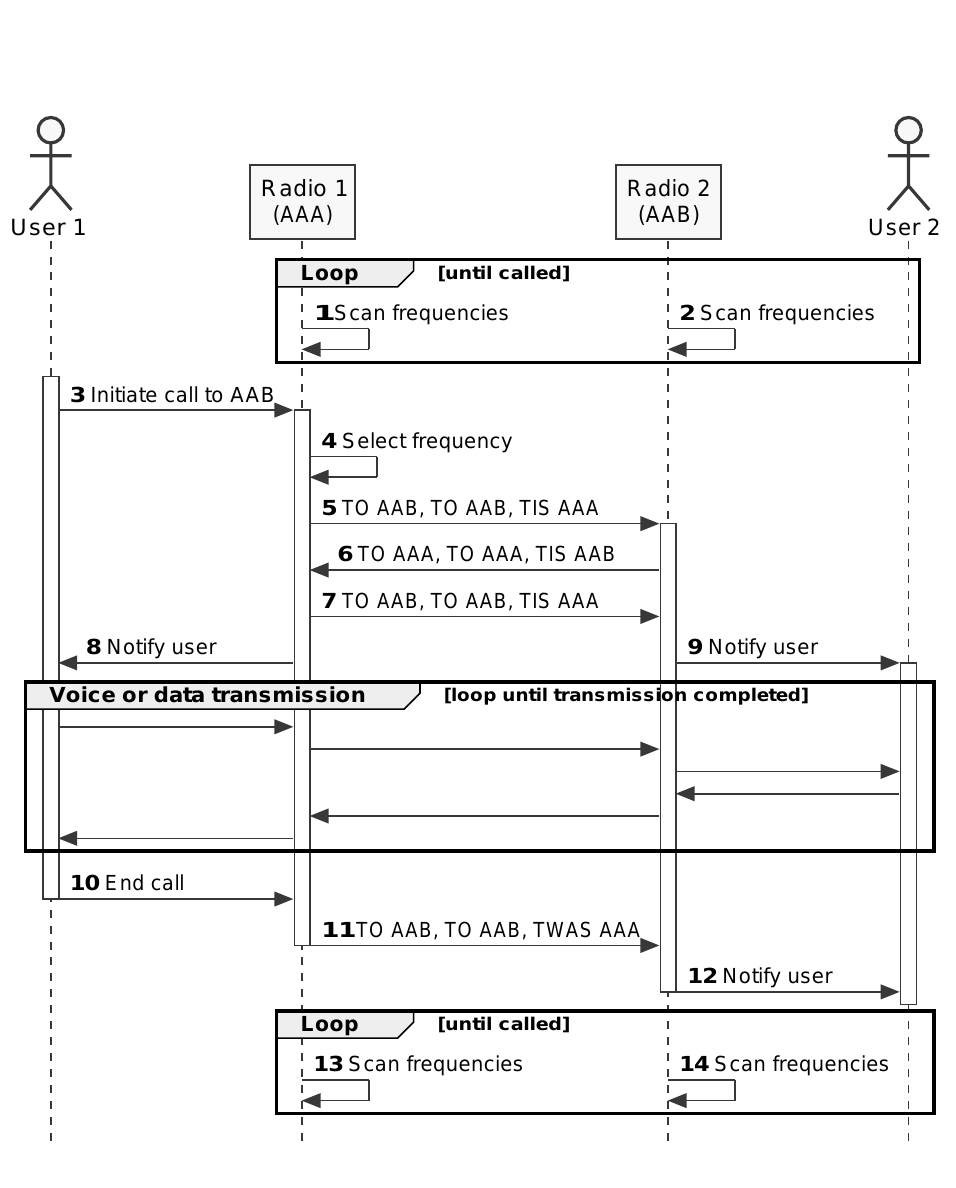
Figure 7: Sequence diagram of a typical 2G ALE call between two radio stations with callsigns AAA and AAB. The users can be either humans or computers, depending on the